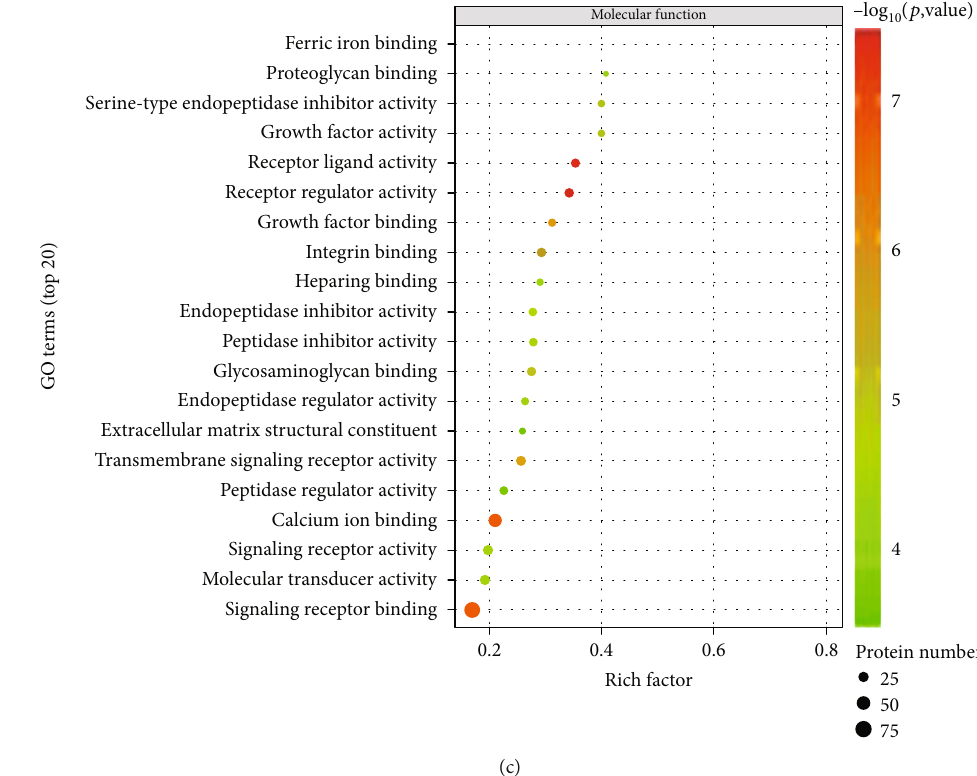
Figure 4: Pro fi ling of di ff erentially expressed proteins using GO analysis. (a) GO annotated statistics of di ff erentially expressed proteins. The gene ontology categories of di ff erentially expressed proteins based on biological processes (BP), molecular functions (MF), and cellular components (CC) between the 12-hour hypoxia-induced group and the control group. (b) As for BP, the upregulated (red) di ff erentially expressed proteins were involved in extracellular structure organization, extracellular matrix organization, extracellular matrix disassembly regulation, cell proliferation, and regulation of cell proliferation. The downregulated (green) proteins were mainly enriched in the positive regulation of cell proliferation, biological adhesion, cell adhesion, platelet degranulation, and humoral immune response categories. (c) In terms of MF, the upregulated (red) proteins were mainly annotated in the receptor-ligand activity, receptor regulator activity, signaling receptor binding, calcium ion binding, and growth factor binding categories. Downregulated (green) proteins were mainly enriched in the peptidase regulator activity, extracellular matrix structural constituent, molecular transducer activity, and signaling receptor activity